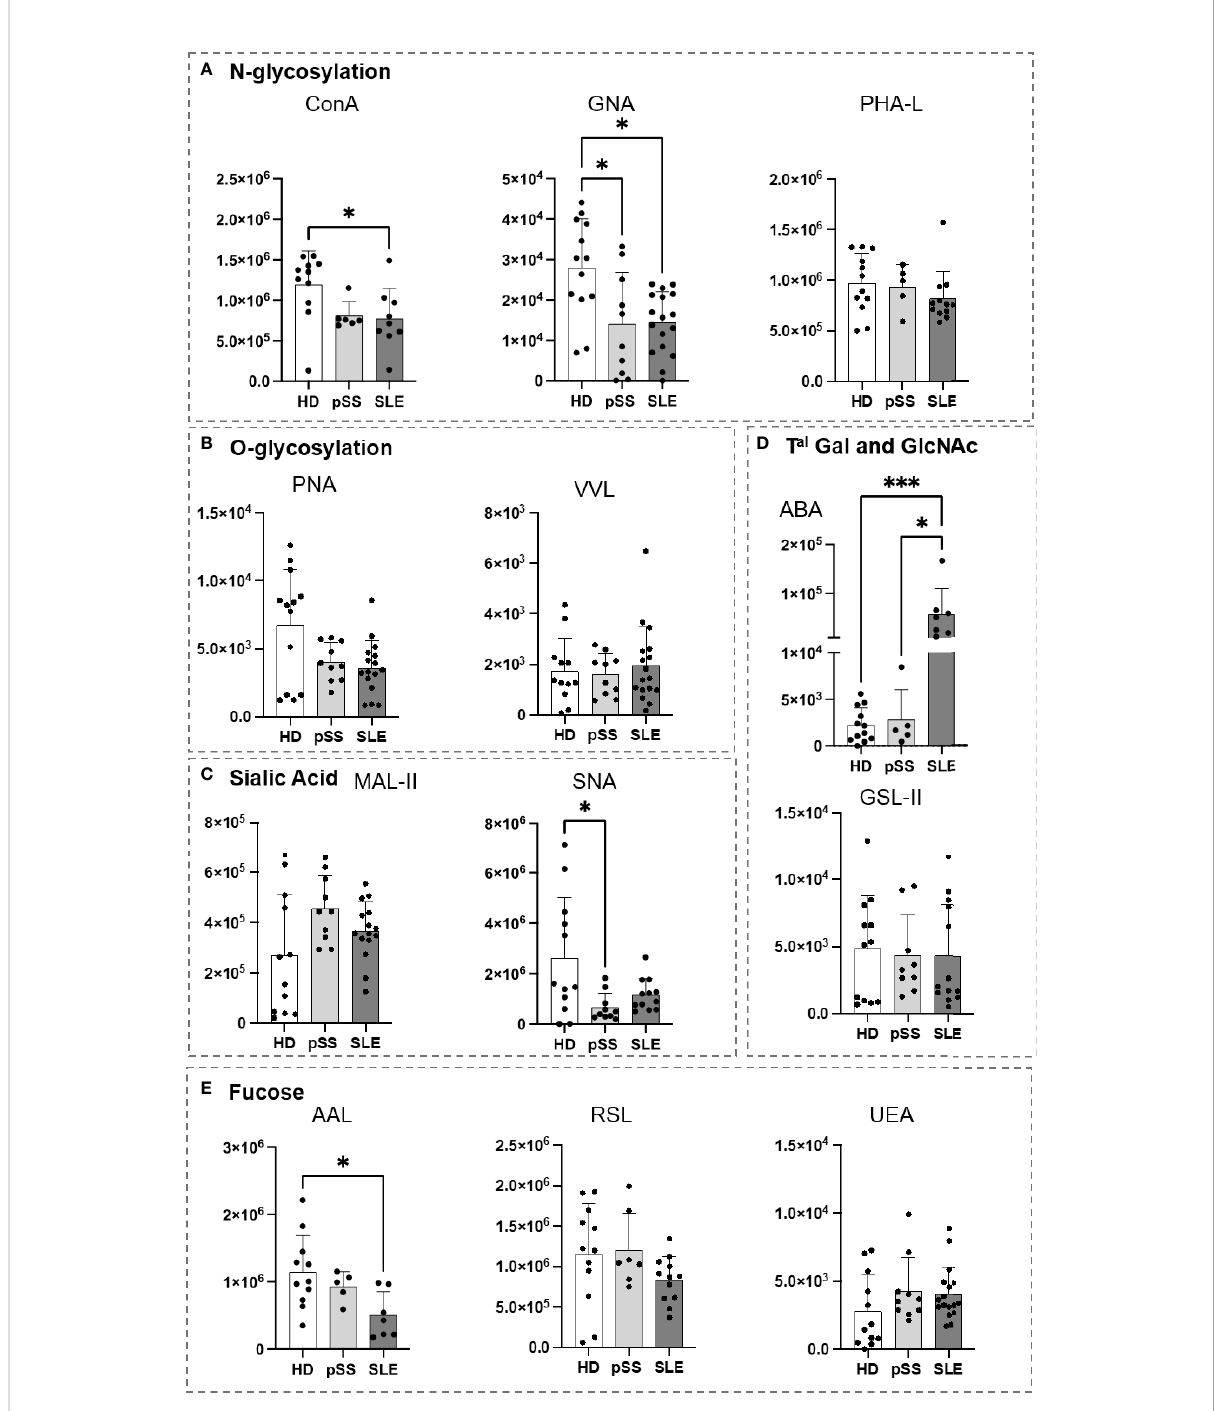
FIGURE 5 Analysis of B cell glycosylation reveals deep alterations in primary Sjögren ’ s syndrome (pSS) and systemic lupus erythematosus (SLE). Freshly isolated peripheral blood mononuclear cells (PBMC) (10 6 ) from 13 healthy donors (HD), 10 pSS, and 17 SLE patients were stained with lectins at 10 µg/mL for 15 min at 4°C (Table 2). After two wash steps, cells were incubated with streptavidin-FITC (5 µg/mL) and an antibody panel (Table 3) for 15 min at 4°C. After staining and washing in PBS at 4°C, cells were analyzed using Beckman Coulter Cyto fl ex S. Fluorescence intensity from CD19+ B cells is expressed as geomean. Results are presented as followed: N-glycosylation in (A) , O-glycosylation in (B) , Sialylation in (C) , Terminal (T al ) Gal and GlcNAc on N and O-glycosylation in (D) , Fucosylation in (E) . One-way anova test followed by Dunn ’ s multiple comparison test were performed. ns: not signi fi cant p > 0,05, stars are indicated when p< 0,05 (*); < 0,001